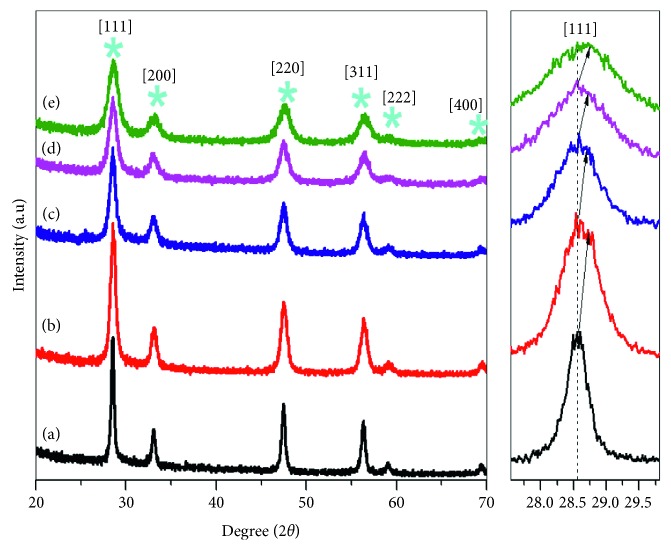
Structural analysis of the MnxCe1−xO2 nanocomposite via the coprecipitation route.